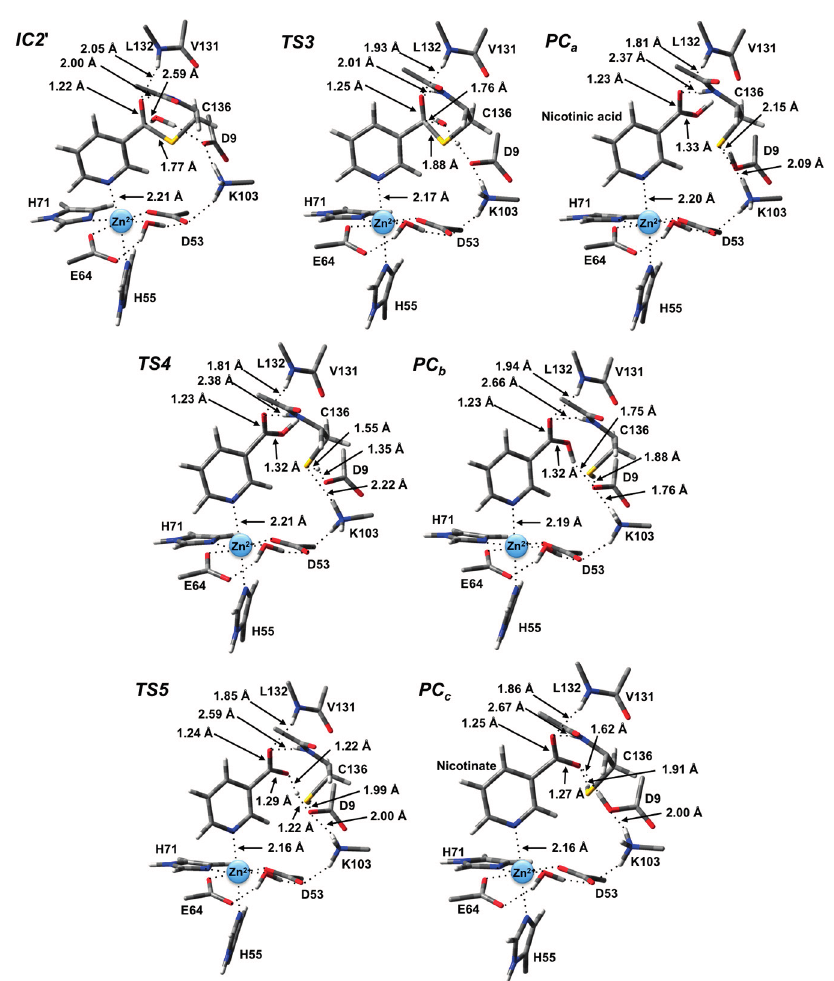
Figure 6. Optimized geometries obtained at the ONIOM(B3LYP/6-31G(d):AMBER96)-ME level of theory of the thioester intermediate + H 2 O ( IC2' ) and other transition states ( TS x = 3 , 4 , 5 ) and product complexes ( PC mechanism of